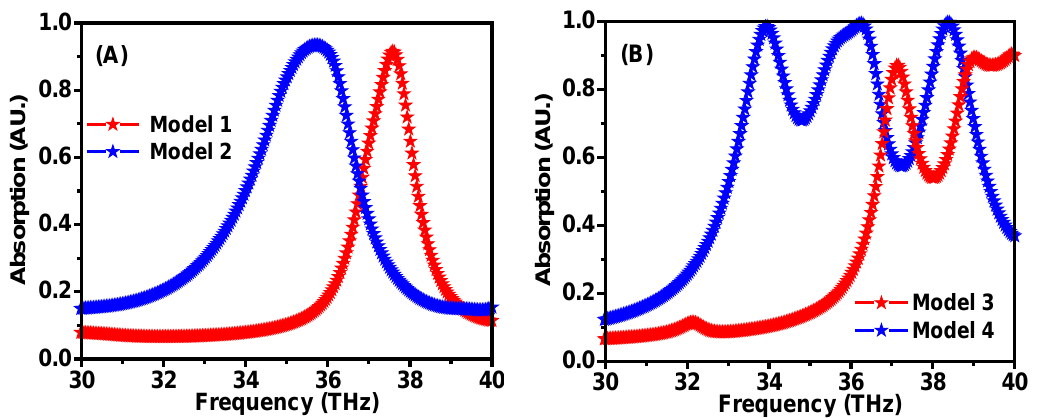
Figure 3. Absorption spectra of Model 1 and 2 ( A ) and Model 3 and 4 ( B ).